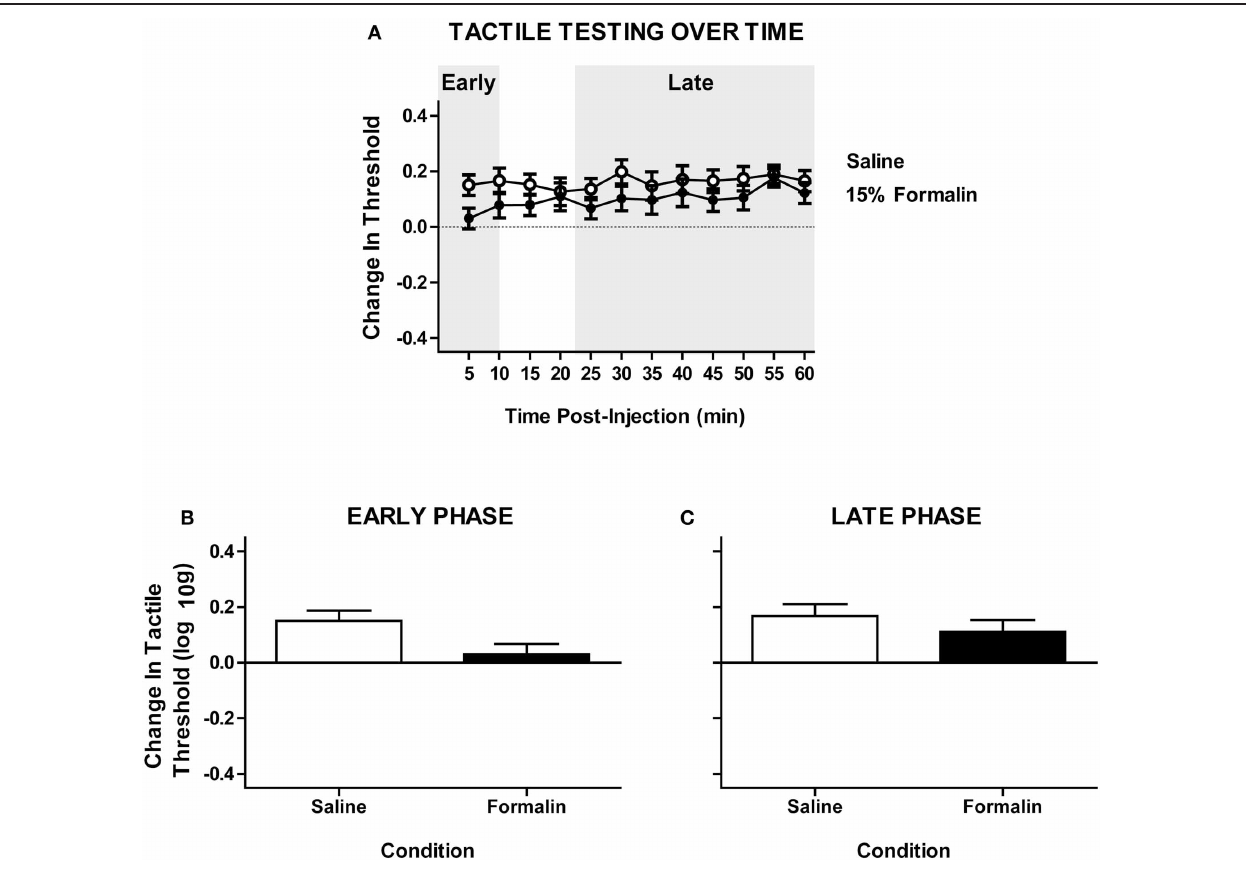
(B) Non-significant trend toward hyper-reactivity on the early phase formalin response contralateral to injection [ F ( 1 , 12 ) = 2 . 17, p = 0 . 166, n = 7 ] rats/formalin condition. (C) Lack of hyper-reactivity in the late phase response, P (cid:3) 0 . 05. Points and bars represent group means ( ±